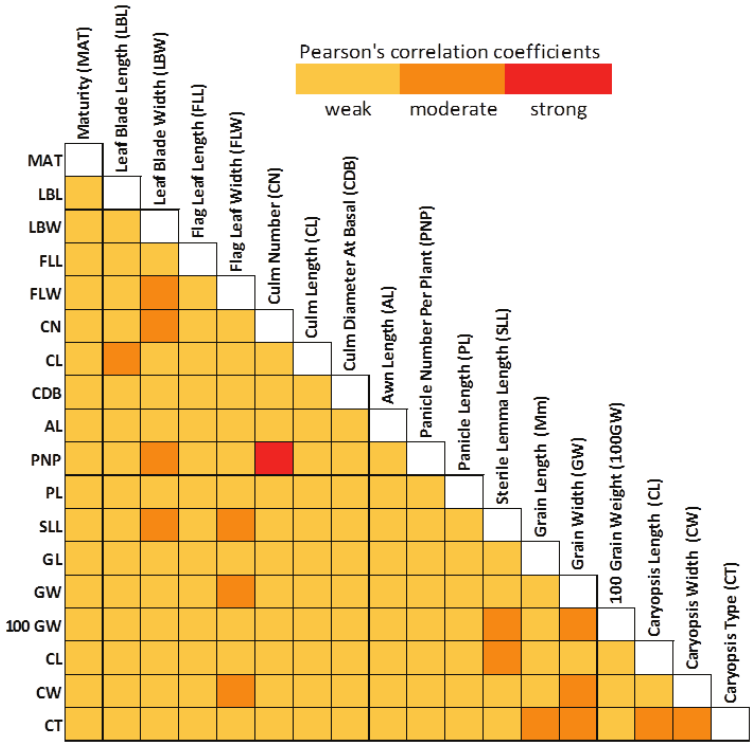
Figure 2. Heat map showing calculated Pearson’s product-moment correlation coefficients among morphological traits measured in all germplasms screened. Correlation